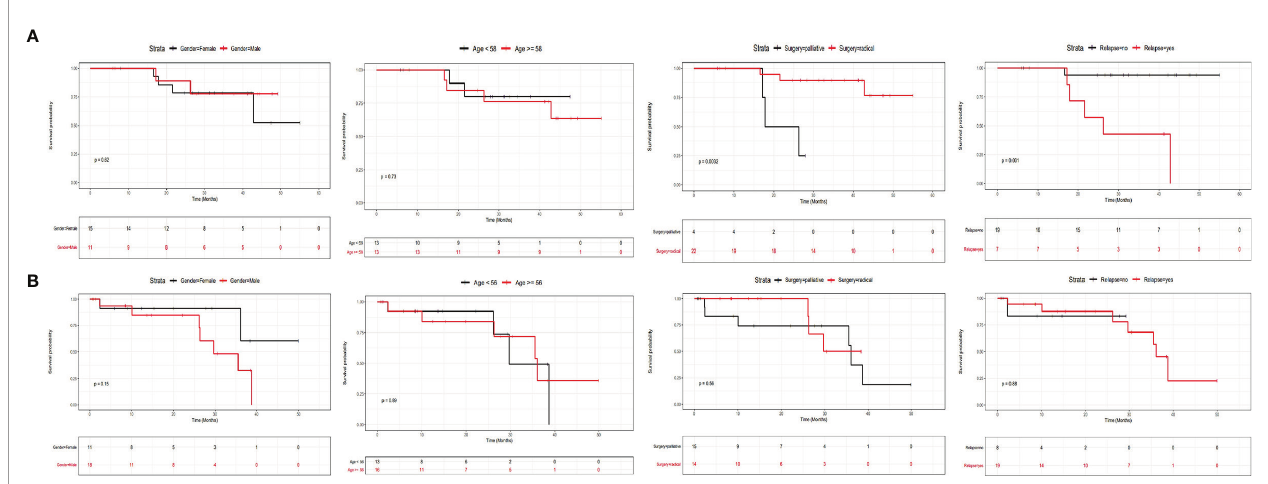
FIGURE 4 | The in fl uence of clinicopathological factors on the prognosis of CRC patients with or without liver metastases. The in fl uence of gender, age, surgery types and relapse status for patients without liver metastasis was shown in (A) , and the in fl uence of these factors for patients with liver metastasis was shown in (B) .